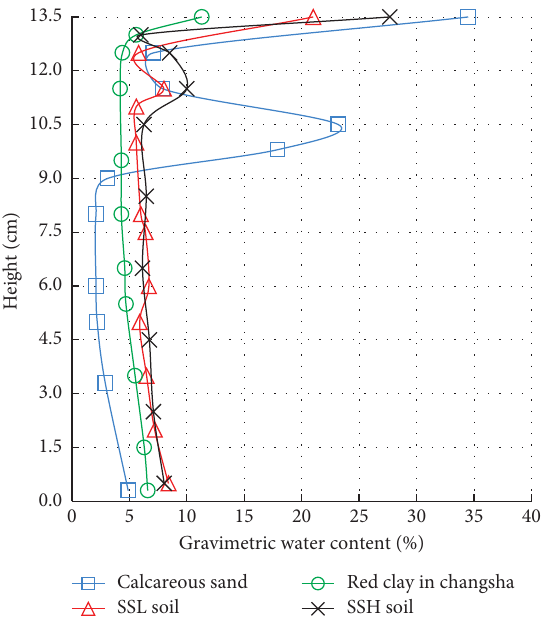
Figure 4: Water content distribution of different soil